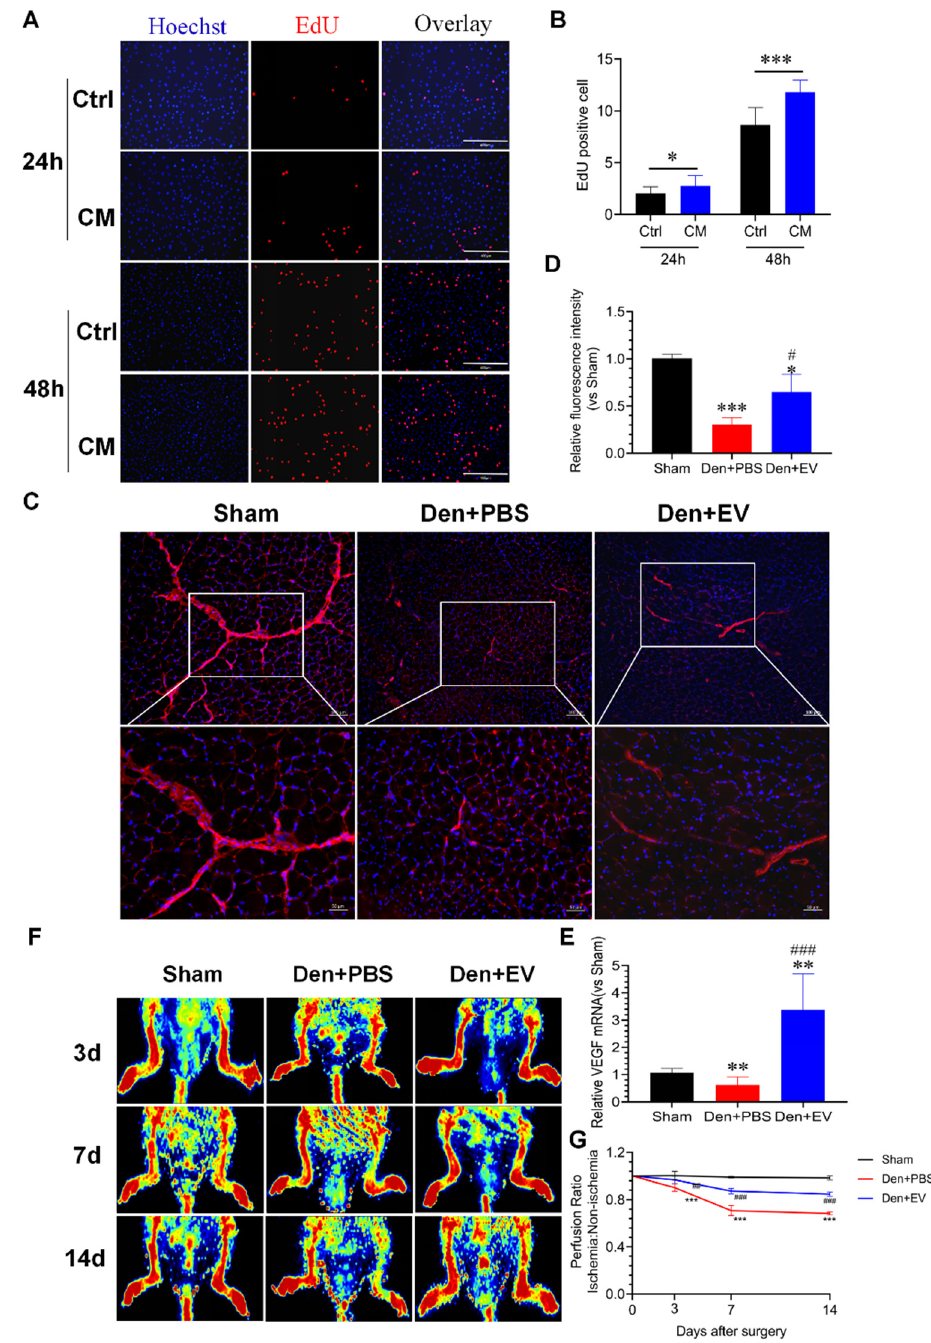
Figure 11. SKP-SC-EVs promote the proliferation of HUVEC cells and improve blood flow reper- fusion in the denervated skeletal muscle. ( A ) EdU staining of HUVEC cells. Scale bar = 400 µ m. ( B ) Histogram showing the effect of the SKP-SC conditioned medium on the proliferation of HUVEC cells. n = 4, * p < 0.05 and *** p < 0.001 vs. Control group. ( C ) The effect of SKP-SC-EVs on the micro-blood flow in denervated skeletal muscles. Red indicates CD31 positive signals, and blue indicates the DAPI-labeled nucleus. Scale bar = 100 µ m (low magnification); scale bar = 50 µ m (high magnification). ( D ) Histogram showing the relative fluorescence intensity of the CD31 positive signal. n = 5, * p < 0.05 and *** p < 0.001 vs. Sham group; # p < 0.05 vs. Den + PBS group. ( E ) qPCR analysis of the expression of VEGF in the tibialis anterior muscle. n = 3, ** p < 0.01 vs. Sham group; ### p < 0.001 vs. Den + PBS group ( F ) Laser Doppler blood flow imaging analysis of the influence of SKP-SC-EVs on the micro-blood flow in the denervated skeletal muscle. ( G ) Histogram showing the blood per- fusion ratio of the ischemic lower limb and the contralateral non-ischemic lower limb at different times after denervation. n = 6, *** p < 0.001 vs. Sham group; ## p < 0.01 and ### p < 0.001 vs. Den +